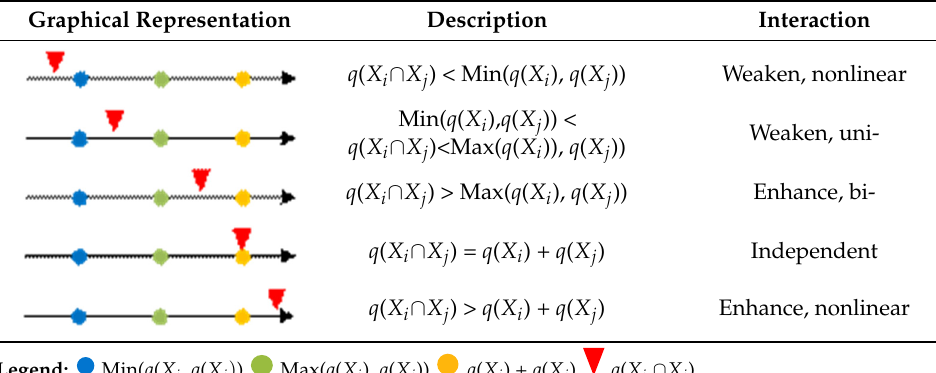
Table 1. Interaction between Explanatory Variables ( X i and X j ).